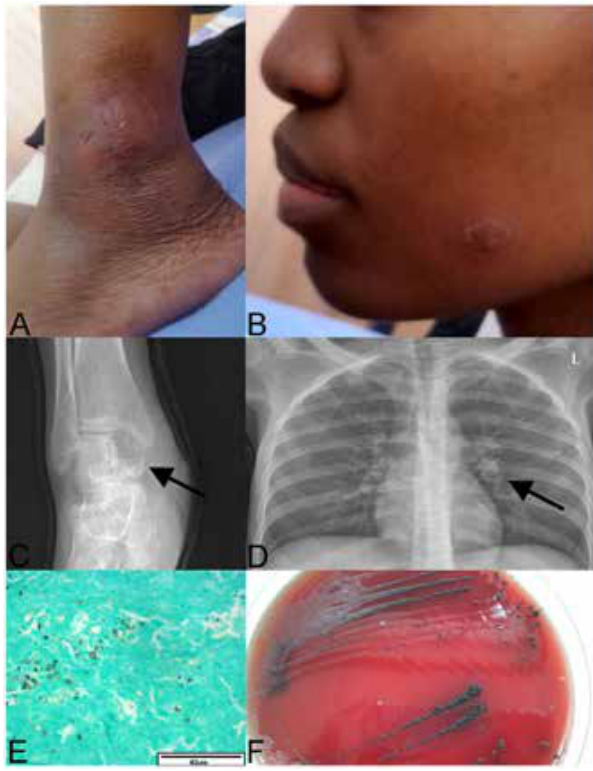
Figure 1: A: Swollen, fluctuant left ankle with sinus formation. B: Well- circumscribed, scaling plaque on the patients face that resolved after treatment with amphotericin B and fluconazole. C: Lytic lesion in the patient’s right talus (arrow), consistent with osteomyelitis. D: Chest X-ray showing a small infiltrate in the left hilar region (arrow). E: Grocott’s stain (40x) showing fibrous connective tissue from the patient’s knee with variable sized fungal elements. F: Aureobasidium pullulans culture on blood agar from blood culture. Colonies were initially small and white, becoming black two weeks